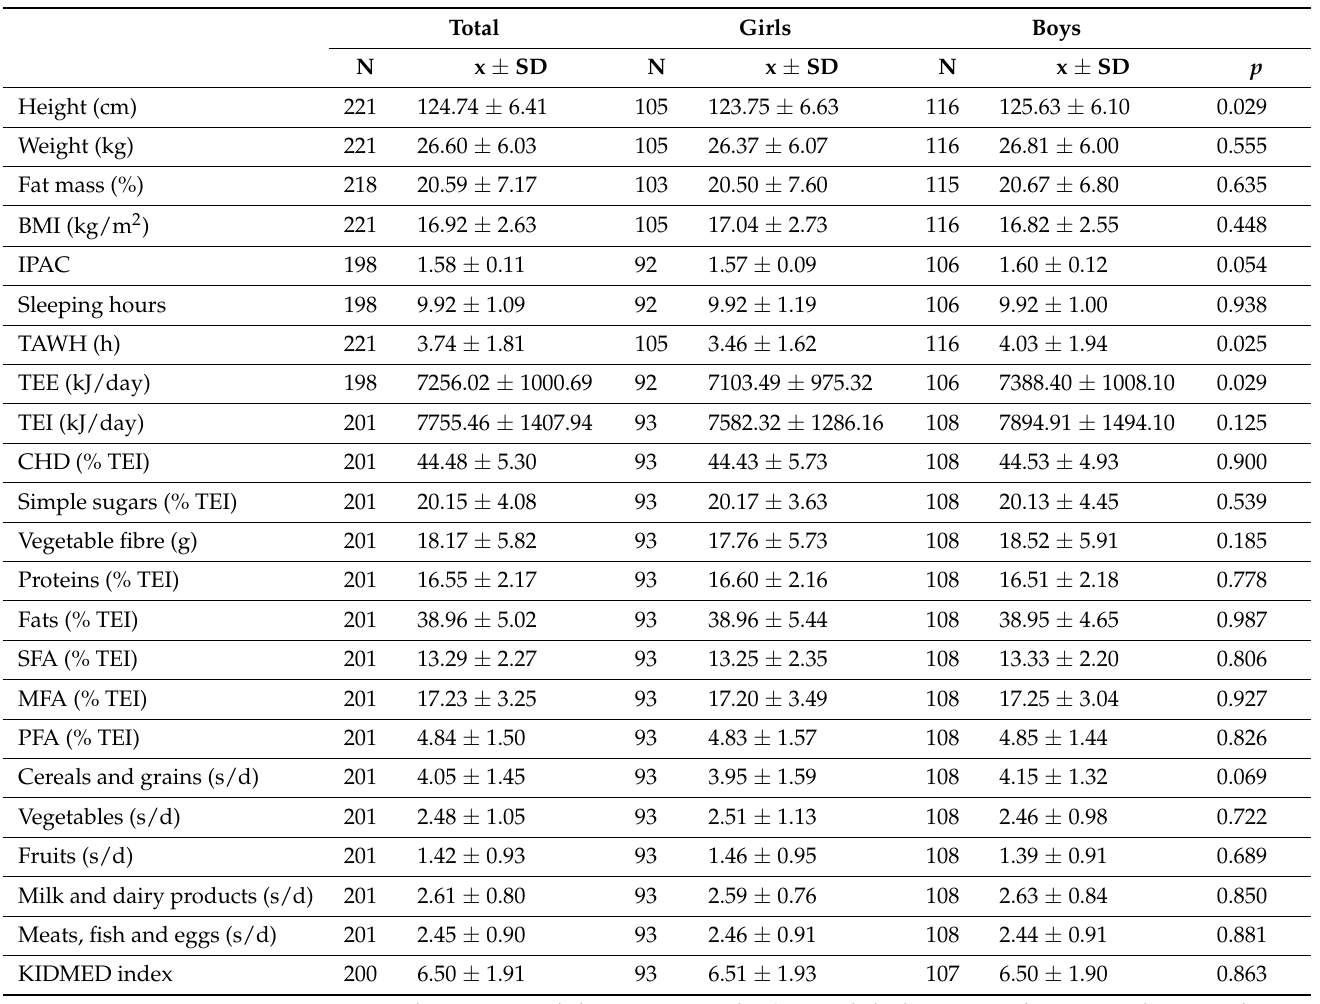
Table 1. Sample characteristics by